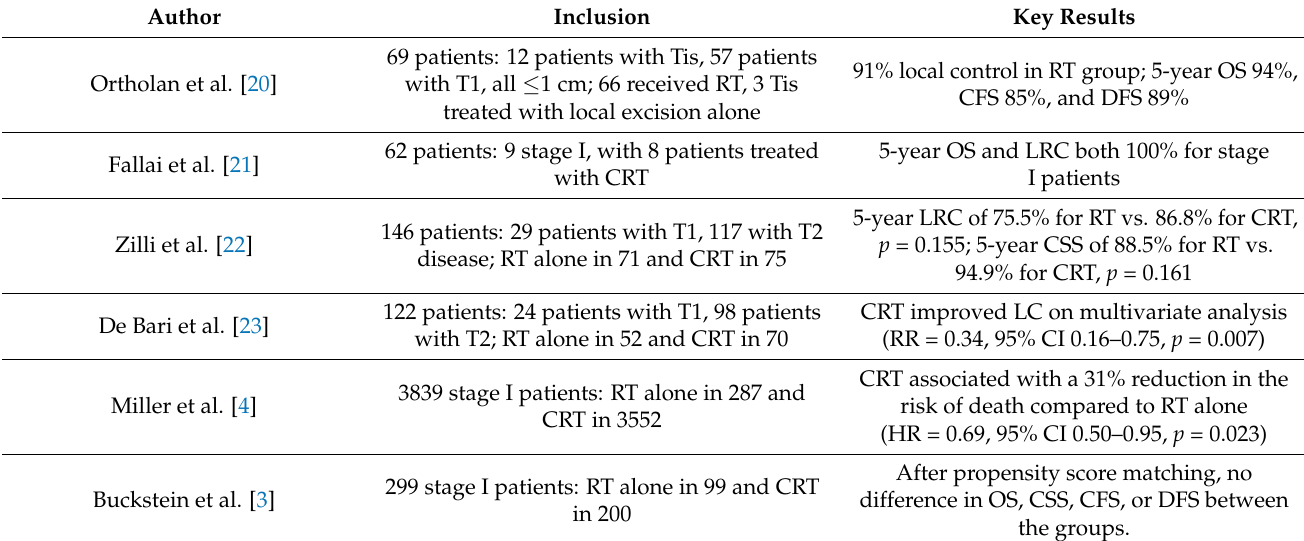
Table 1. Select studies evaluating radiation therapy (RT) alone or comparing chemoradiation (CRT) to RT in early-stage anal